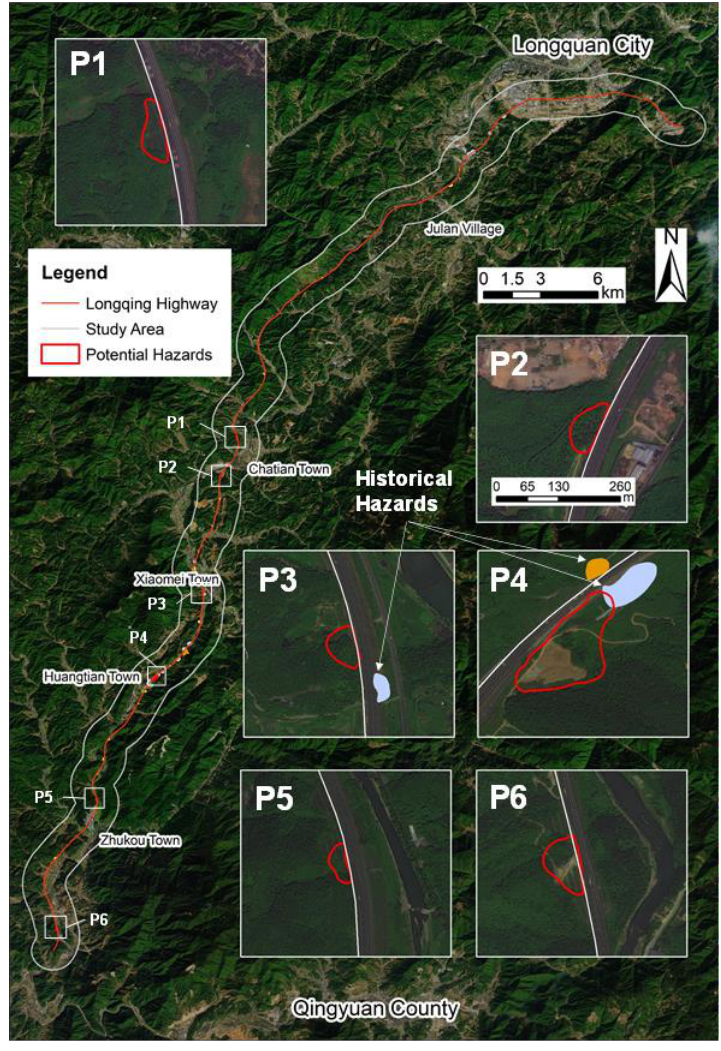
Figure 7. Potential hazards identification based on the combined procedure.